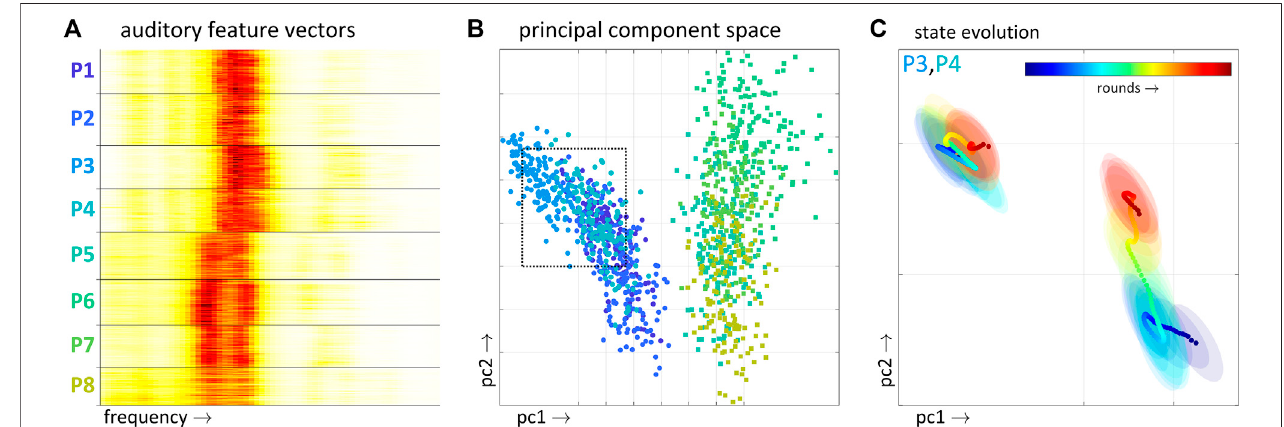
FIGURE 6 | Example of vowel state estimation. (A) Vowel-midpoint auditory spectra for each token of boc . Actual feature vectors consist of a temporal series of suchspectra,i.e.,auditoryspectrograms. (B) Firsttwoprincipalcomponentsofauditoryspectrogramsof boc .The fi rstcomponentencodesmuchofthegender-related variation. (C) Smoothed state-space trajectories over the experiment for players P3 and P4, exemplifying convergence; region shown corresponds to dashed box in panel (B)